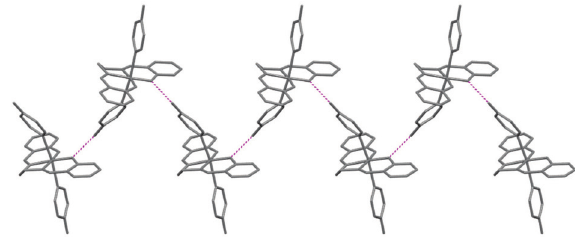
Figure 5. View of a zig-zag infinite chain in compound 2 .